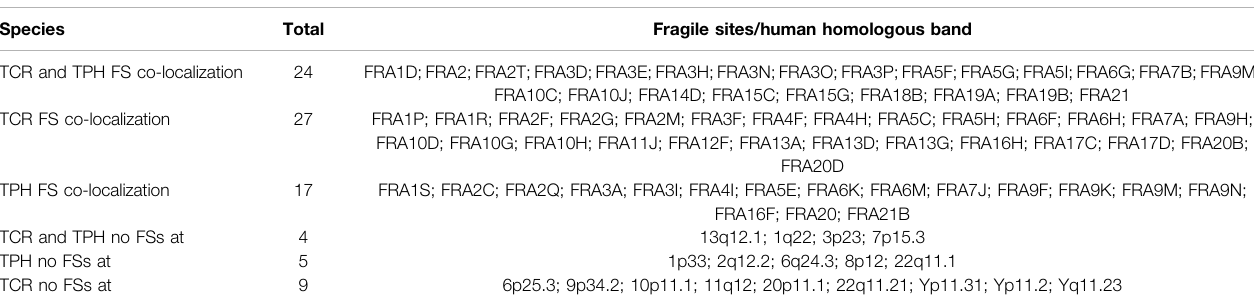
TABLE 4 | ECBs in TPH and TCR colocalizing with human FSs.